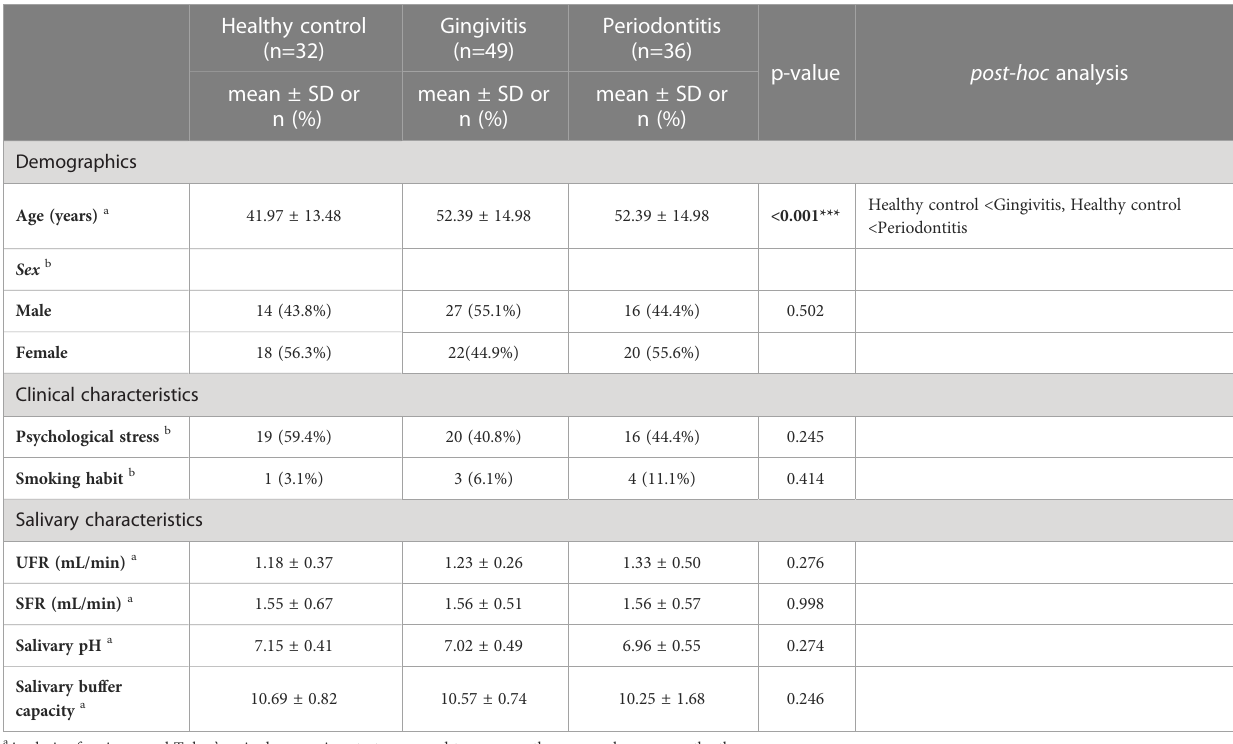
TABLE 1 The demographic, clinical, and salivary characteristics of participants by